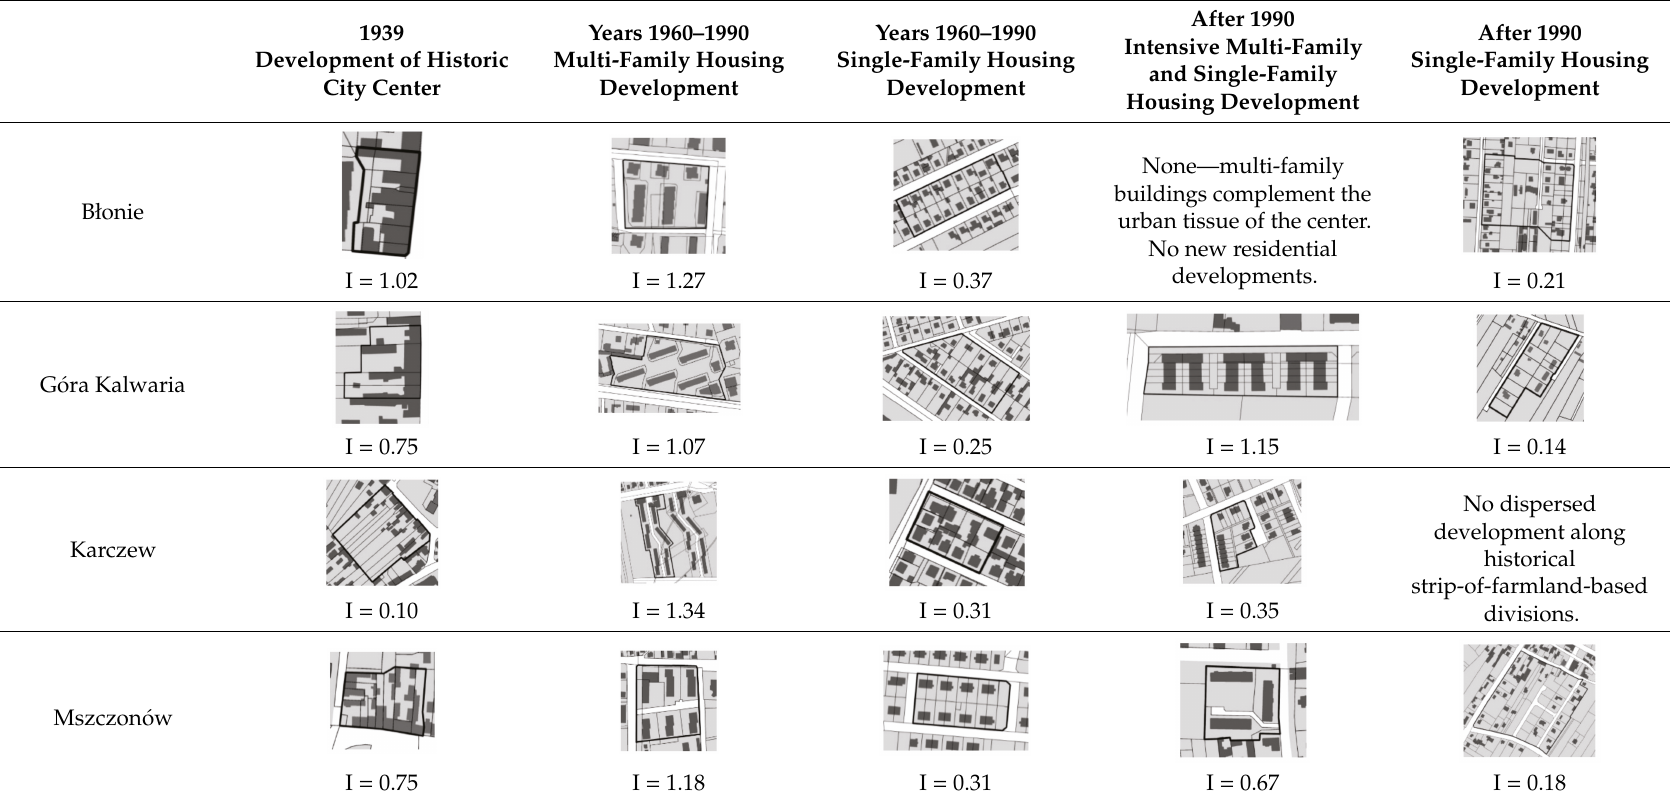
Table 5. Types of use of plots of land since 1939 and the intensity of their